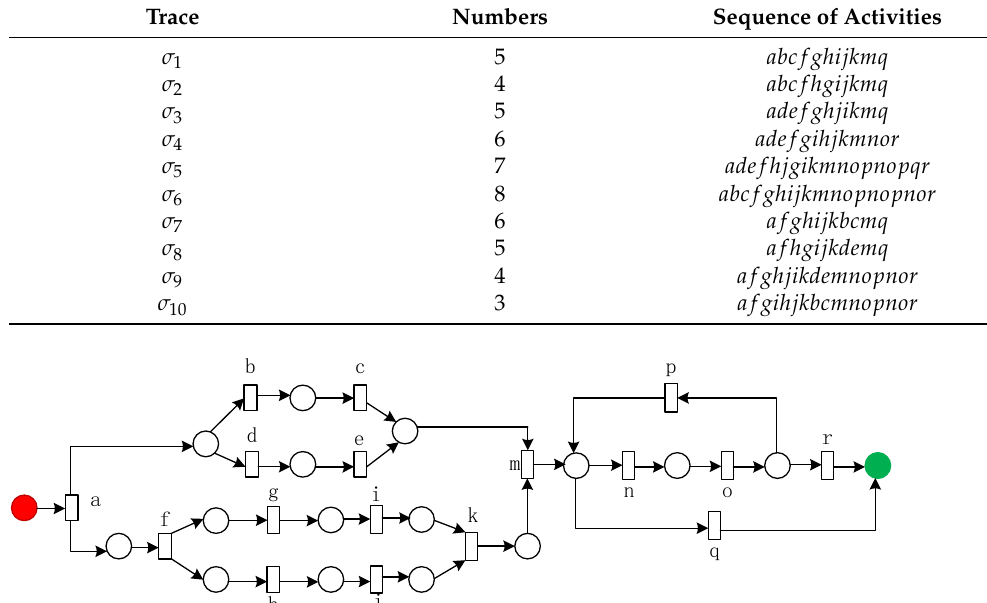
Table 3. An event log L 2 .